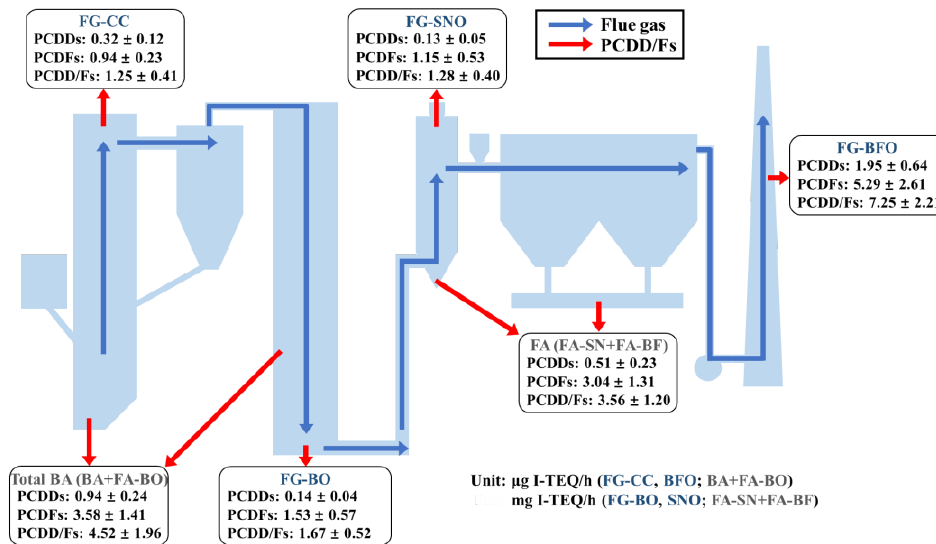
Figure 7. Flow chart of integrated PCDD/Fs on I-TEQ level.